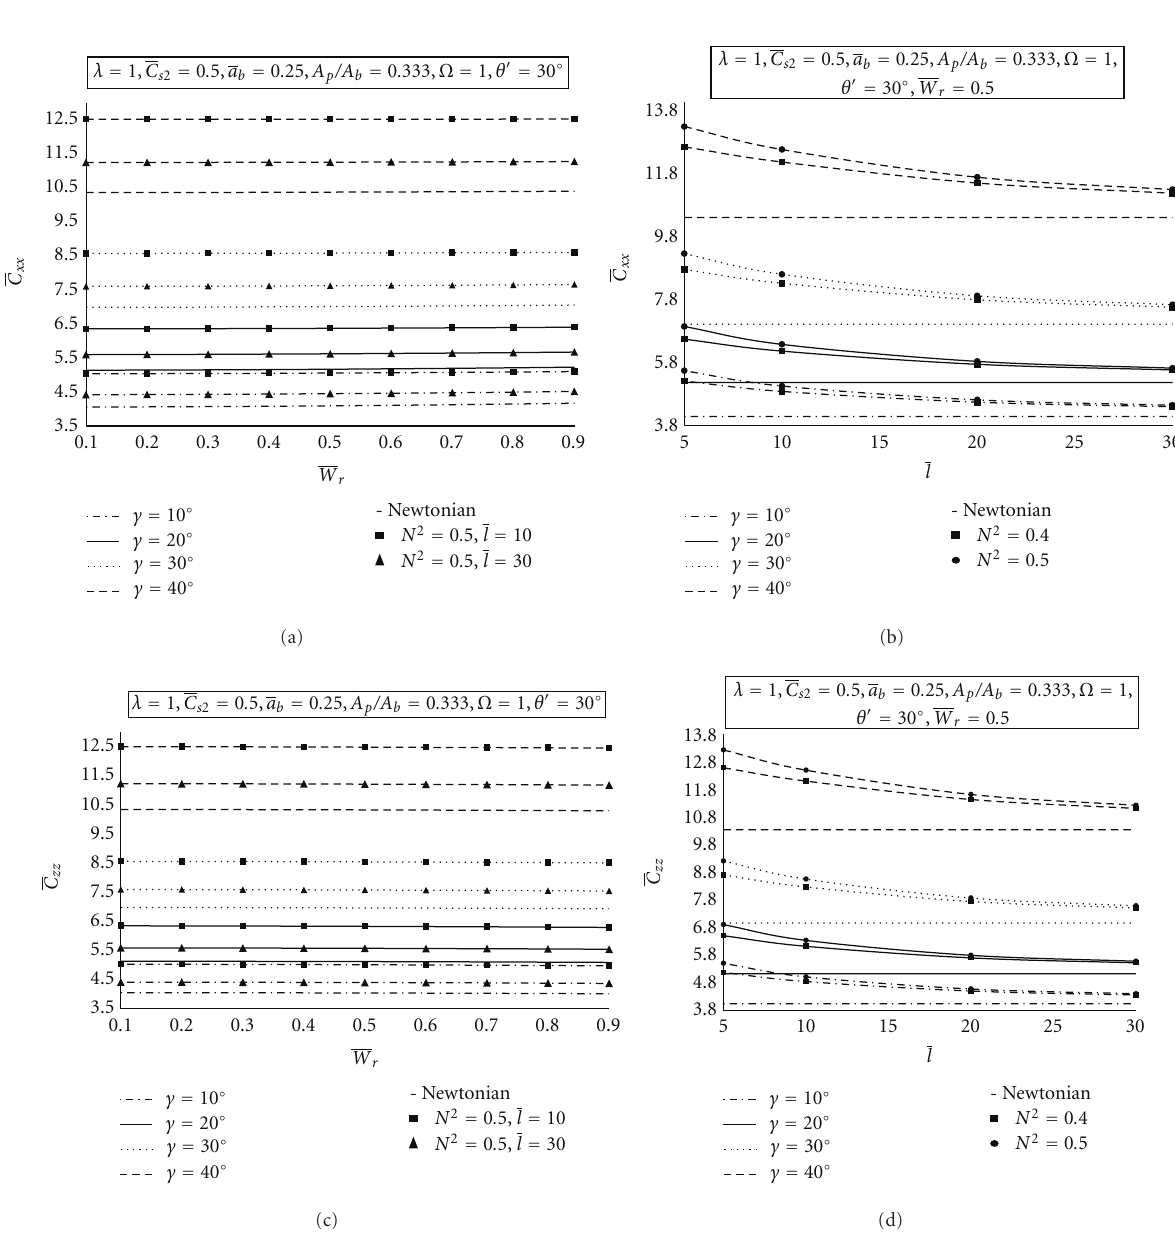
Figure 10: (a) Variation of C xx versus radial load W r . (b) Variation of C xx characteristic length l . (c) Variation of C zz versus radial load W r . (d) Variation of C xx characteristic length l